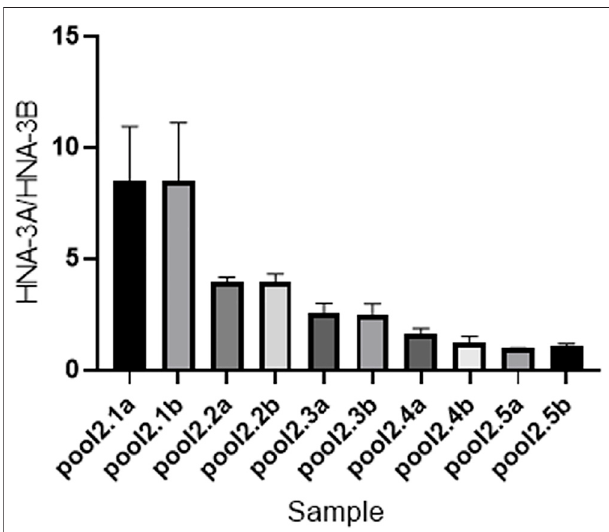
FIGURE4| Concentrationratiosofchannel1(FAM,HNA-3A)tochannel 2 (VIC,